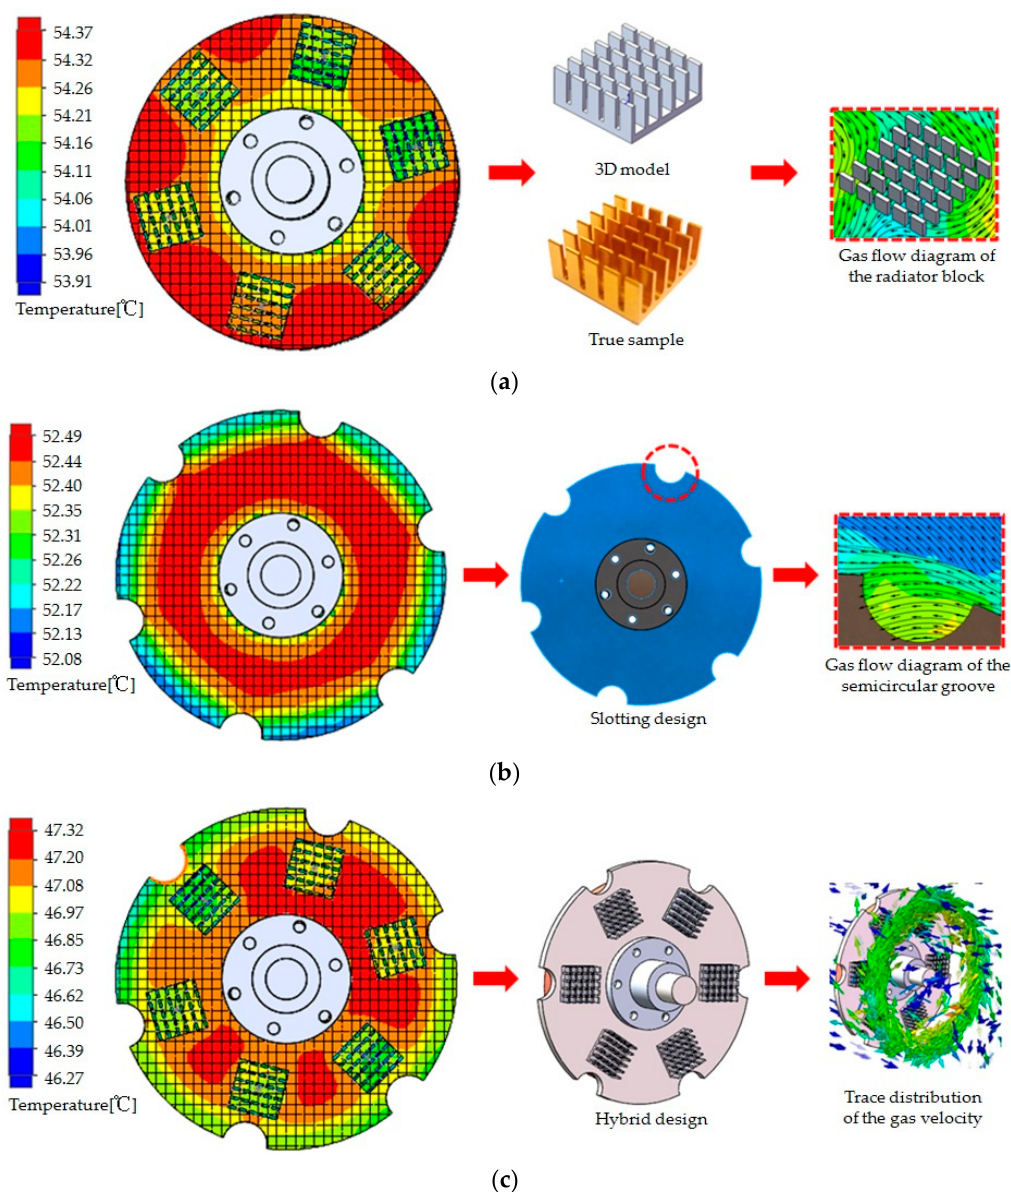
Figure 10. 3D model and temperature field simulation results. ( a ) Scheme I. ( b ) Scheme II. ( c ) Scheme